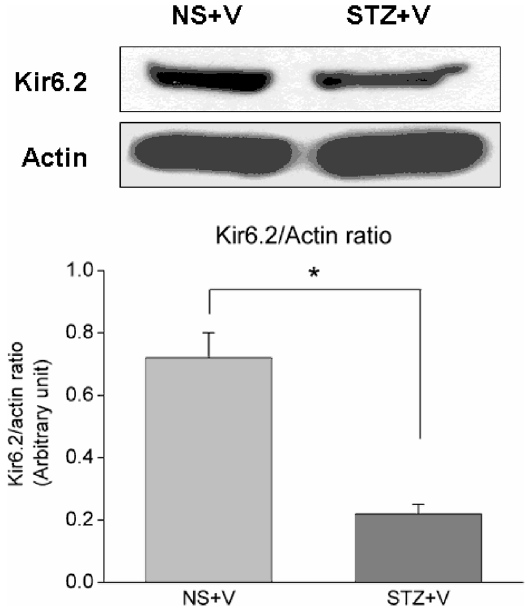
Figure 5. Representative Western blots showing Kir6.2 protein expression in the hippocampus in the NS + V and STZ + V groups. Immunoblots of 100 m g of tissue lysate from rats in the two groups against Kir6.2 antibody. (Unpaired t -test, n=5 per group, * p , 0.05).